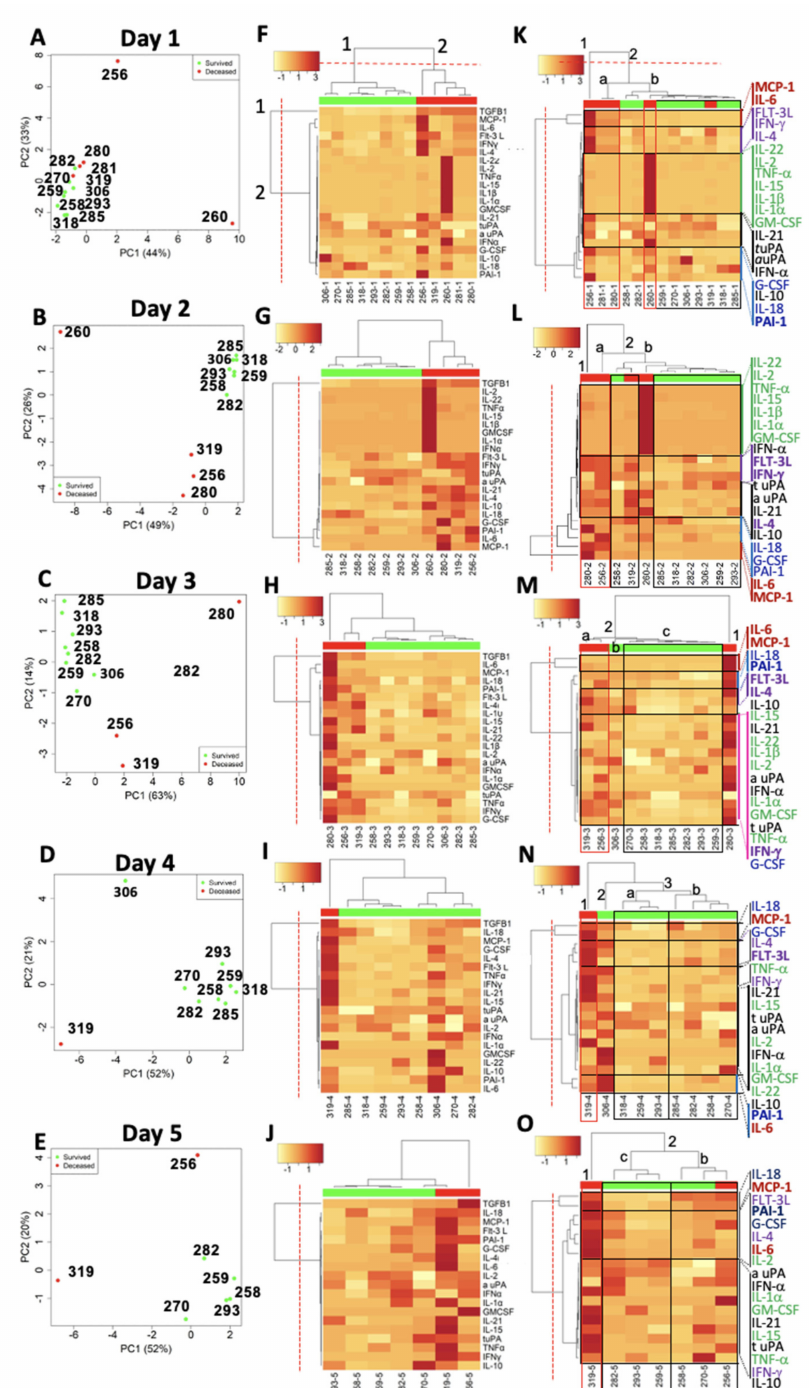
Figure 5. Differential expression of inflammatory mediators in longitudinal plasma samples of HCPS distinguish between survivors and non-survivors. ( A – E ) Principal component analysis (PCA) of inflammatory mediators 15 cytokines, a uPA, t uPA, PAI-1 N, L, and M in 2 Class I (318 and 285), 6 Class II patients (258, 259, 270, 282, 293, and 306), and 5 Class III patients (256, 260, 280, 281, and 319). Each panel corresponds to days (day 1–5) of sample collection. ( F – J ) Heat map cluster analysis-based Euclidean distance similarity between inflammatory mediators of survivors (green horizontal bar) and non-survivors (red horizontal bar). Inflammatory mediator clusters (rows) are listed on the right edge of the heatmap, and patient clusters (columns) are indicated on the top edge. The colors represent the log-concentration range. ( K – O ) Heat map cluster analysis recapitulated with TGF- β 1